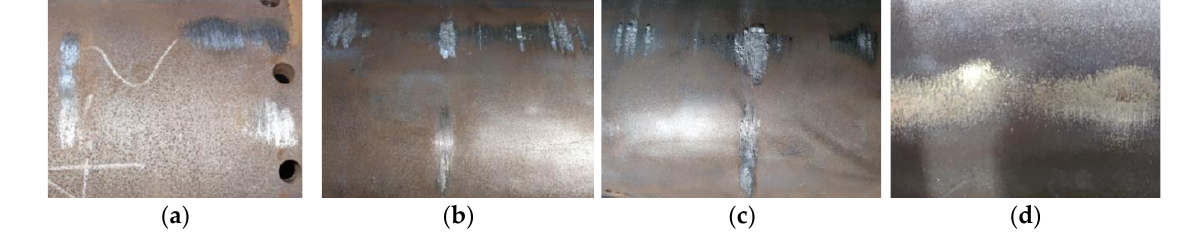
Figure 10. Local wear on the friction surface of the lower arc end-plate of each specimen under an equal amplitude loading protocol: ( a ) H350-1-1; ( b ) H350-2-1; ( c ) H350-3-1; ( d ) H350-4-1.